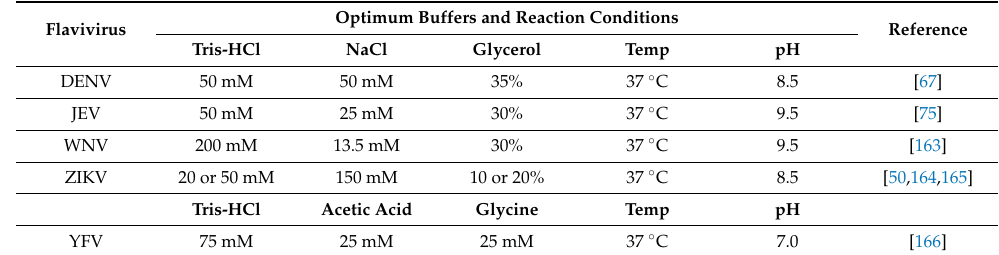
Table 2. In vitro reaction conditions for the optimum proteolytic activities of various flavivirus NS2B-NS3